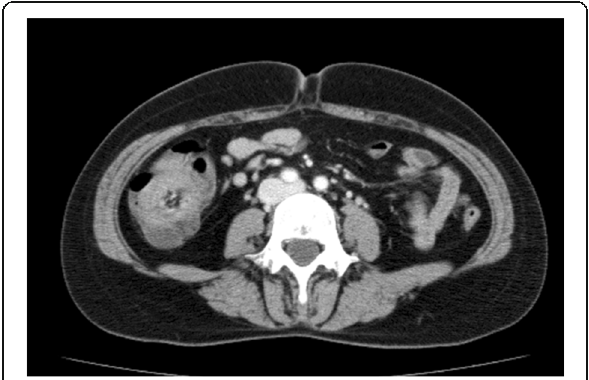
Fig. 2 Abdominal computed tomography showing cecal wall